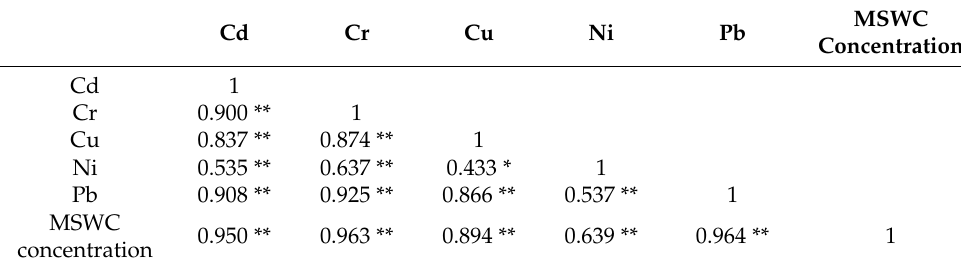
Table 3. Correlation matrix between the heavy metal concentration of MSWC and soil. Cd Cr Cu